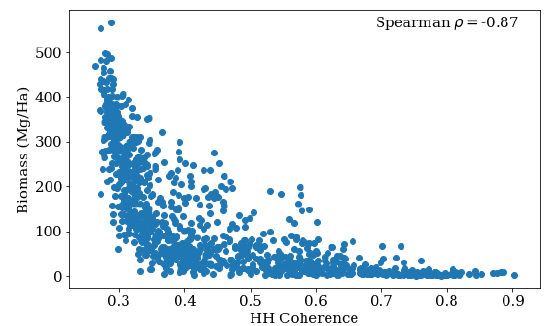
Figure 8. Coherence (PALSAR-2) and AGB at Mondah using superpixels with size at least 6.25 ha (25 pixels) and at least 30% of of pixels with canopy. Spearman ρ shown.